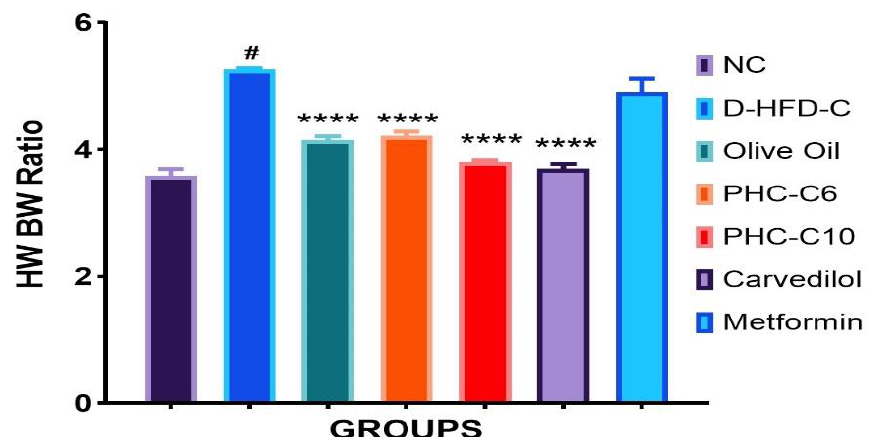
Figure 3. Heart weight/body weight ratio. All values are expressed as mean ± SD ( n = 6) analyzed by one-way ANOVA followed by Tukey’s t -test. D-HFD-C was compared with NC ( # p < 0.0001), and the result was found to be highly significantly different. The different treatment groups were compared with D-HFD-C, and the results were found to be different at the significance levels and **** p < 0.0001. NC is normal control; D-HFD-C is diabetic high-fat diet control group; PHC6 and PHC10 are polyherbal combination treated groups.